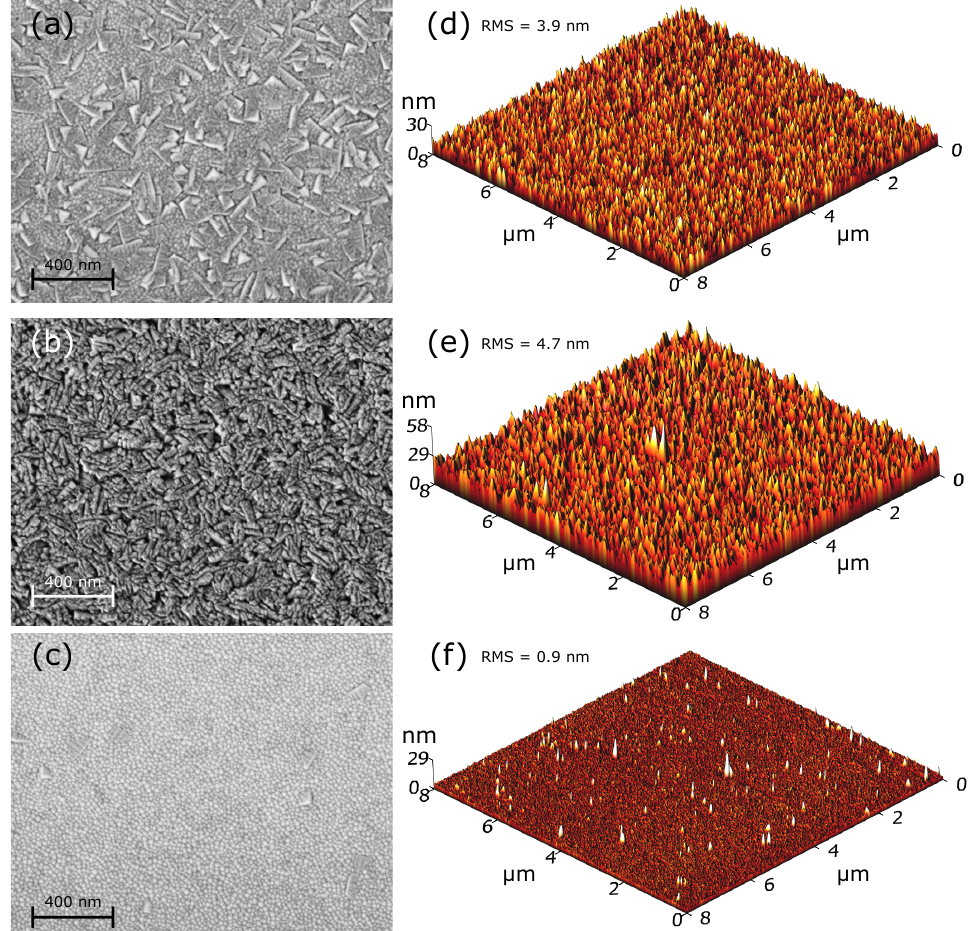
Figure 4. ( Left column) SEM and ( right column) AFM images of the samples produced at ( a , d ) a pressure of 0.2 Pa and an N 2 /Ar ratio of 27%, ( b , e ) pressure of 1.0 Pa and N 2 /Ar ratio of 27% and ( c , f ) pressure of 0.2 Pa and N 2 /Ar ratio of 50%. Magnetron power is kept constant at 600 W. RMS values are given in correspondence to every AFM